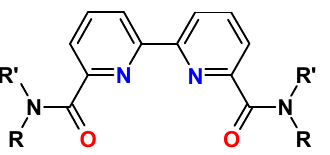
Figure 4. Diamides of 2,2′-dipyridyl-6,6′-dicarboxylic acid ( BPyDA ).